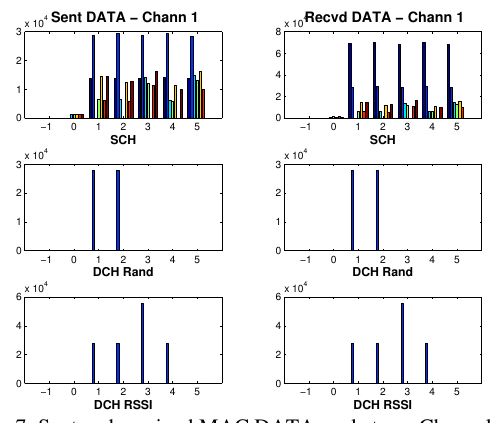
Figure 7: Sent and received MAC DATA packets on Channel l To understand how the dynamics of the different forms of Figure 4: Numbers of application packets sent to node 0 (left bar) AODV affected performance we conducted detailed analyses for and received by node 0 (right bar) for each node for SCH, DCH each node of the number of AODV messages and packets sent and Rand and DCH AODV. received.